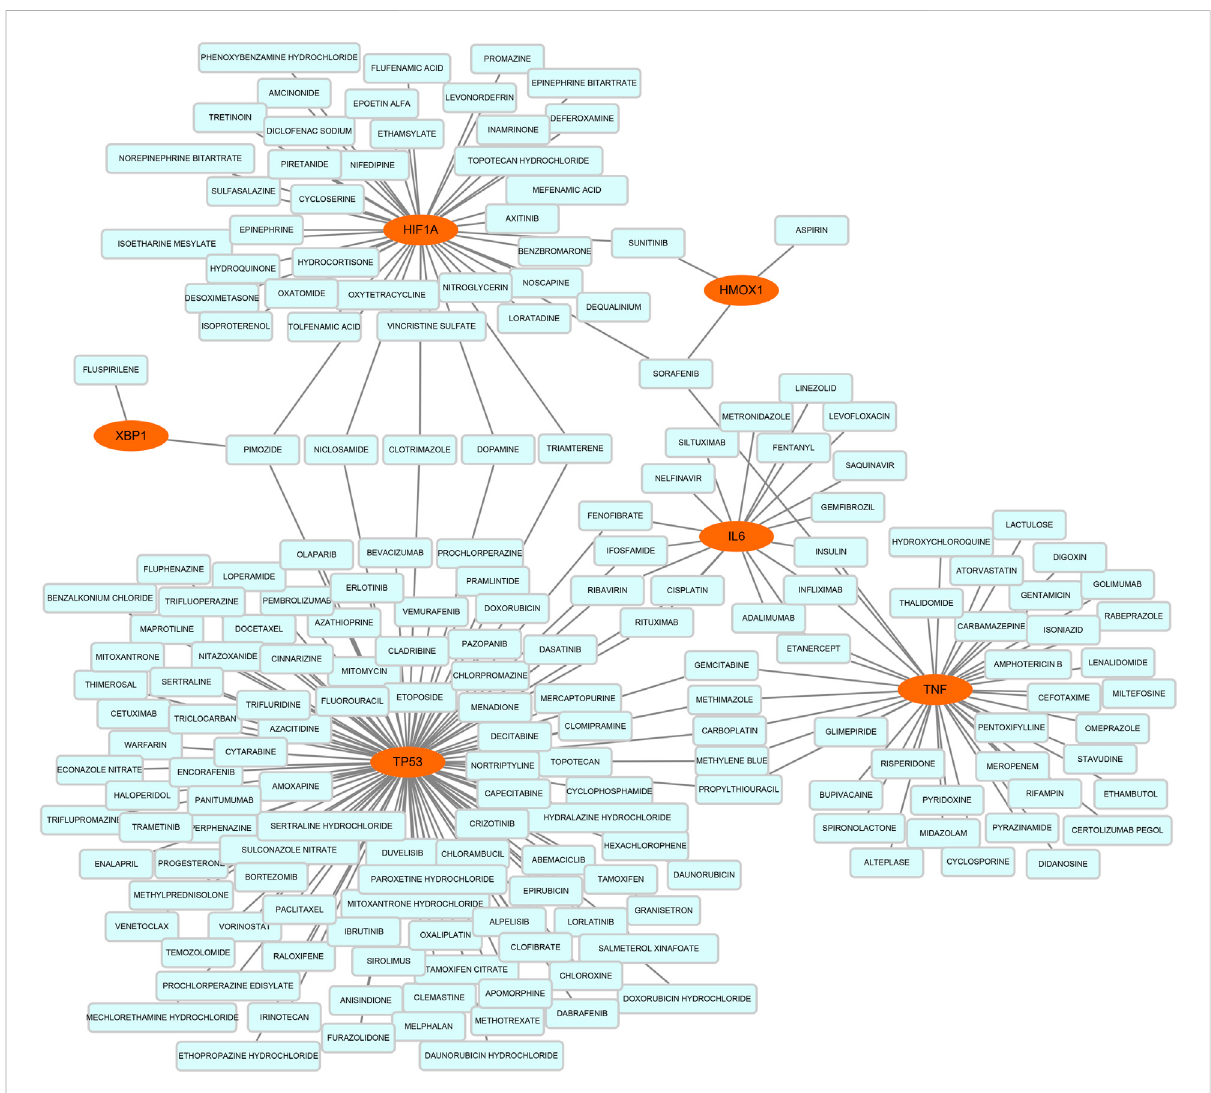
FIGURE 6 Based on the Drug – Gene Interaction database, the network of predicted drug – gene pairs was constructed via Cytoscape and consist of 6 hub genes and 191 drugs.